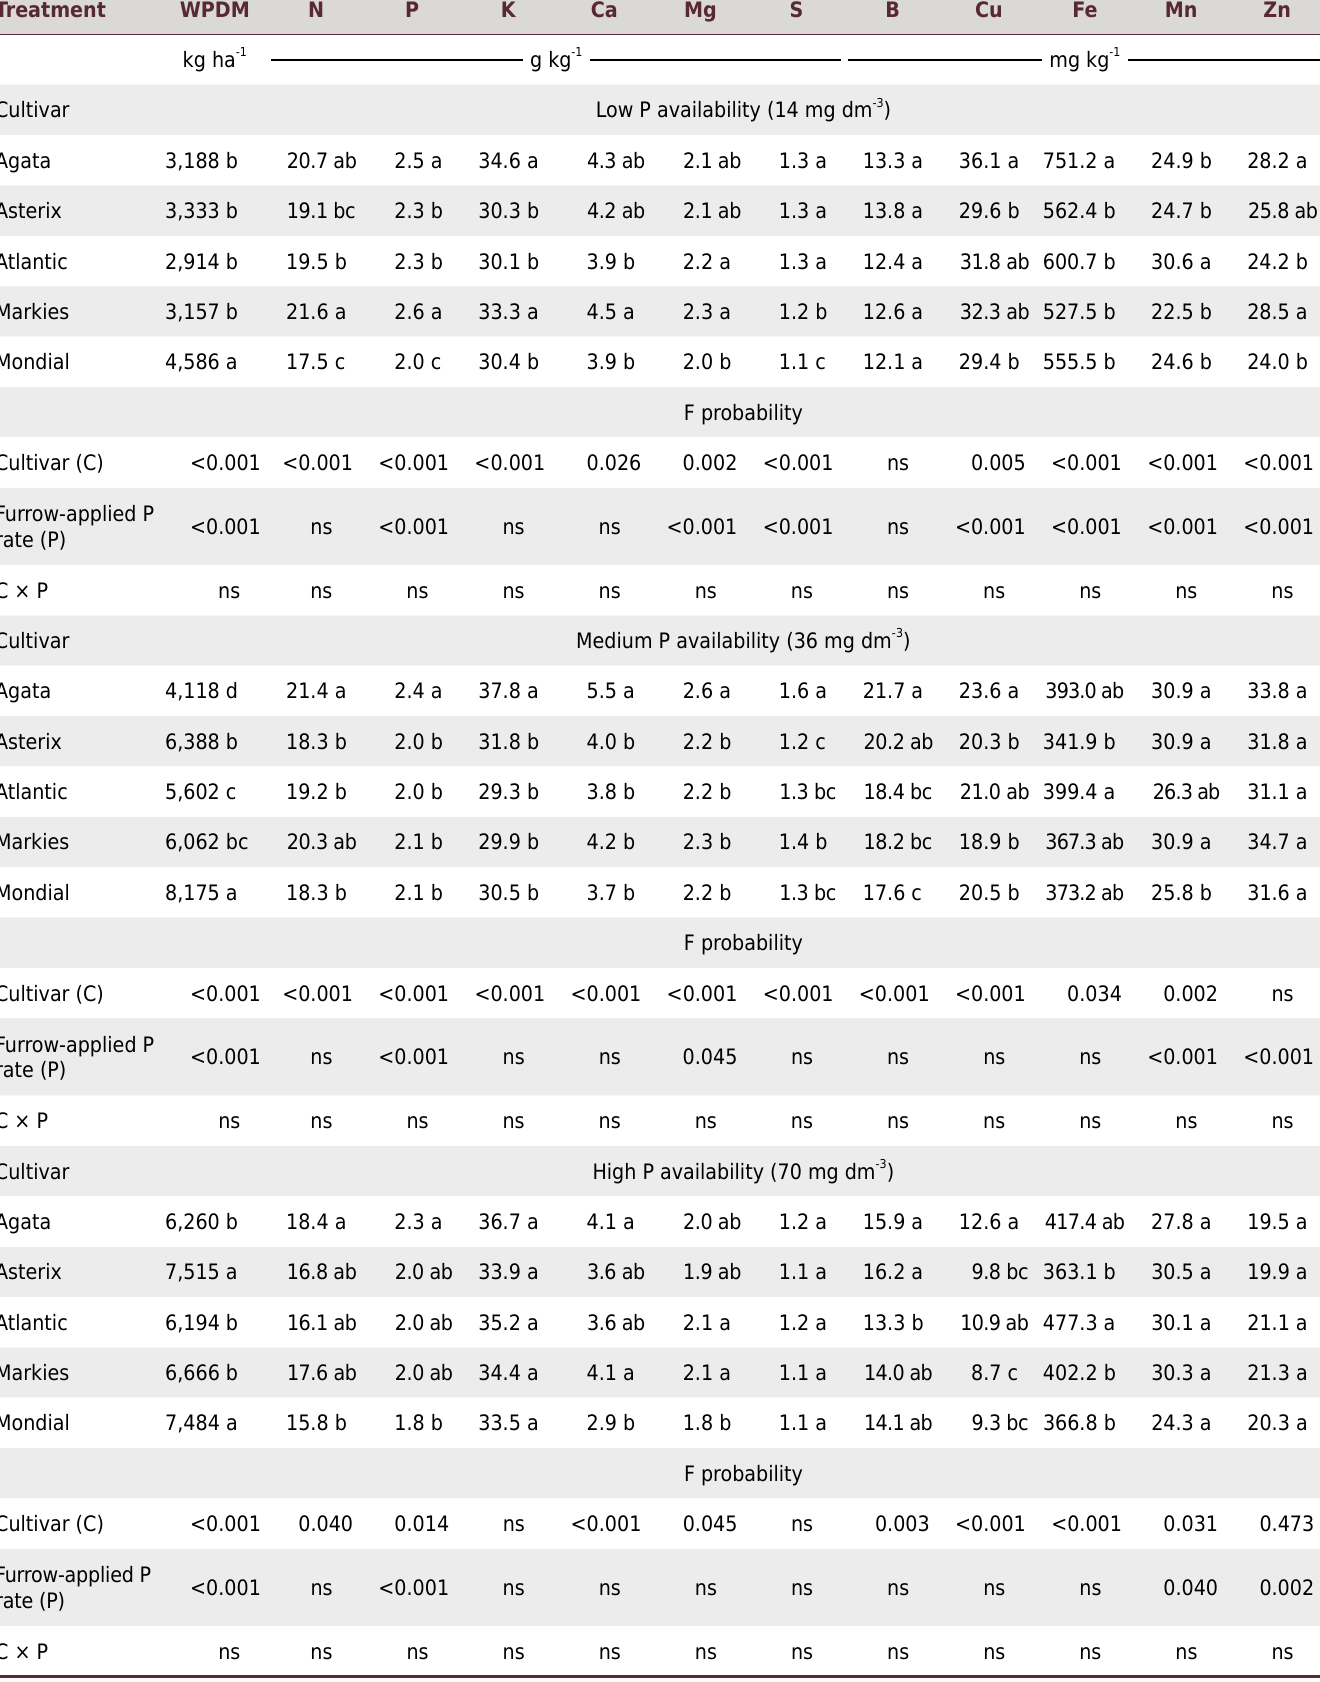
Table 2. Whole plant dry matter accumulation (WPDM) and nutrient (N, P, K, Ca, Mg, S, B, Cu, Fe, Mn, and Zn) concentrations in the whole plant of five potato cultivars as affected by rates of P applied in the planting furrow in soils with low, medium, and high P